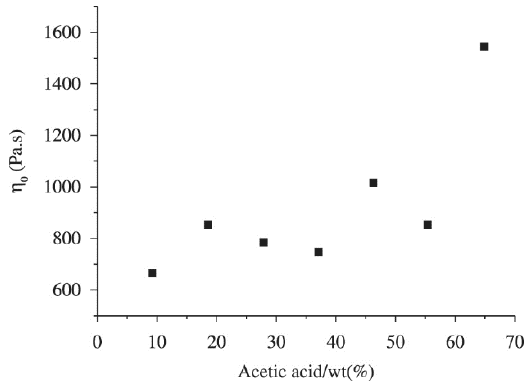
Figure 6. Zero-shear viscosity versus acetic acid concentration of gelatin /